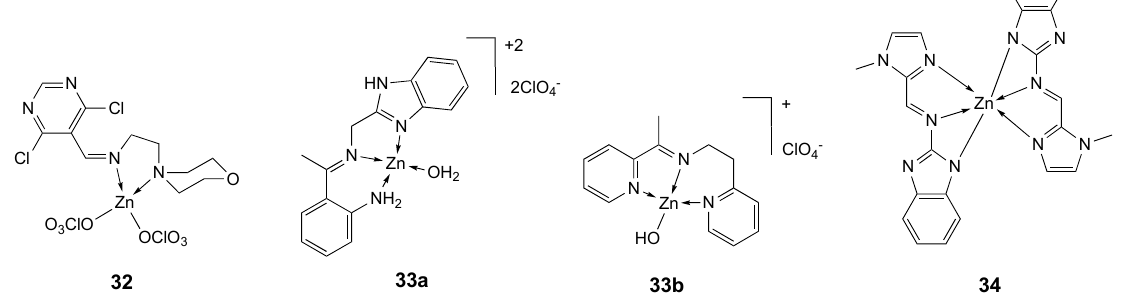
Figure 18. Structure of the zinc complexes 32 , 33a , 33b and 34 .